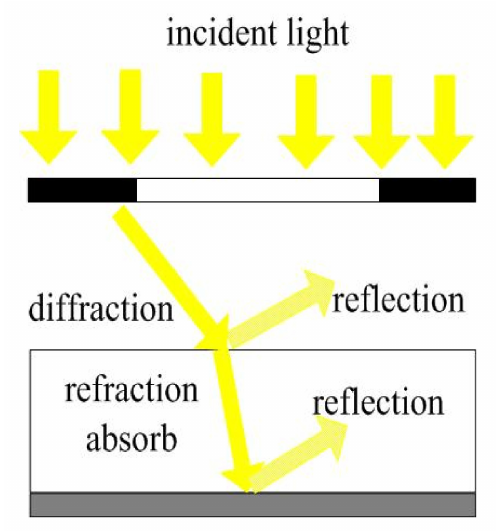
Figure 1. Light propagation process.